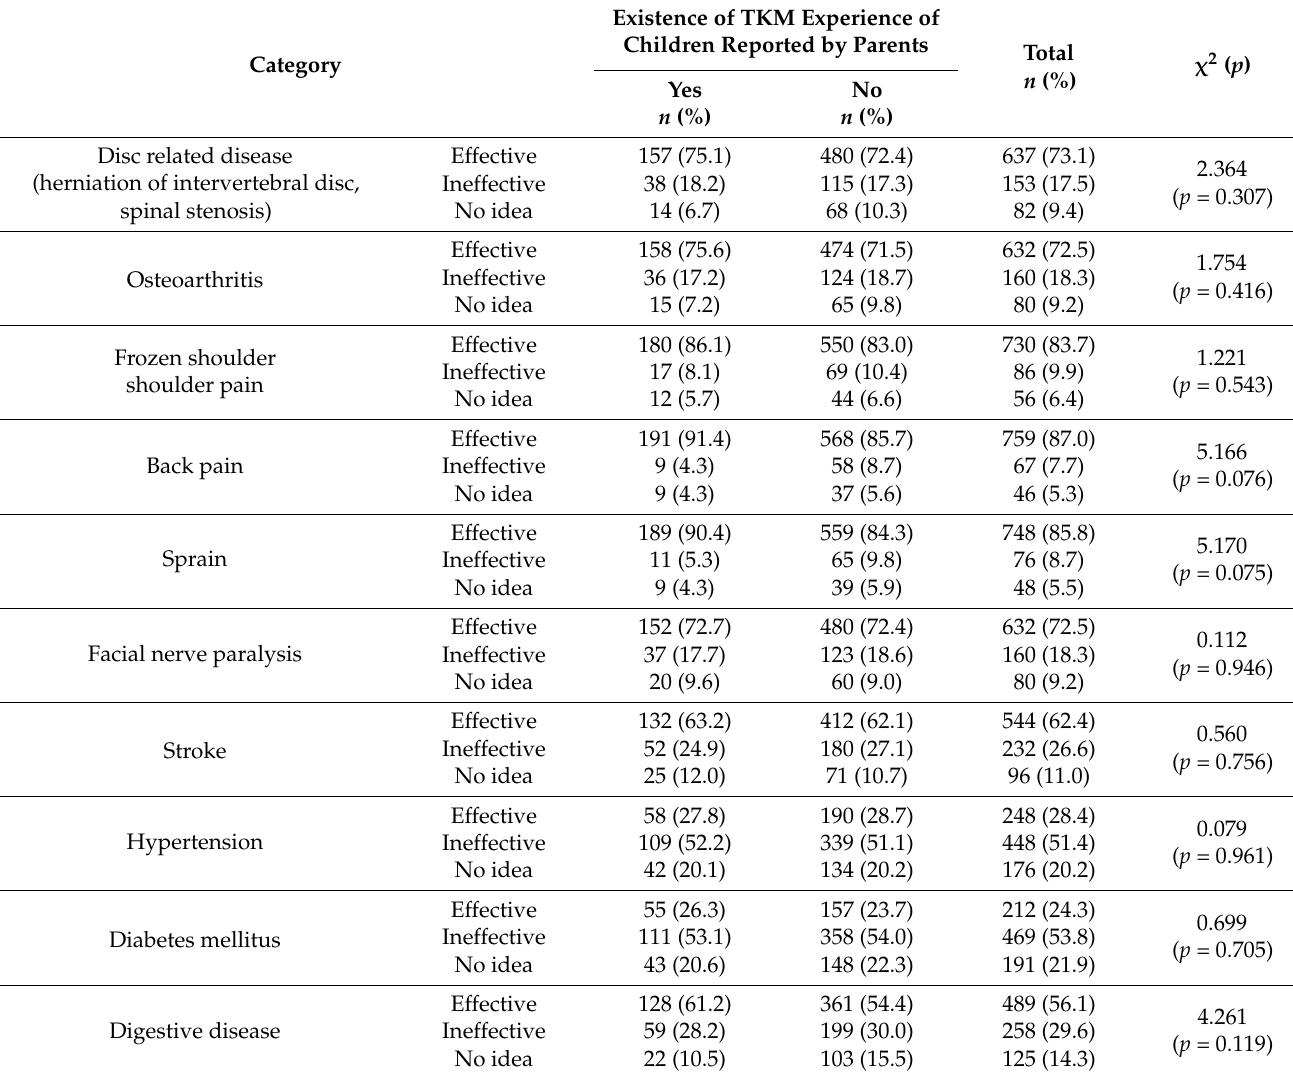
Table 4. Perception of the TKM effectiveness of diseases of survey respondents with and without TKM experience of